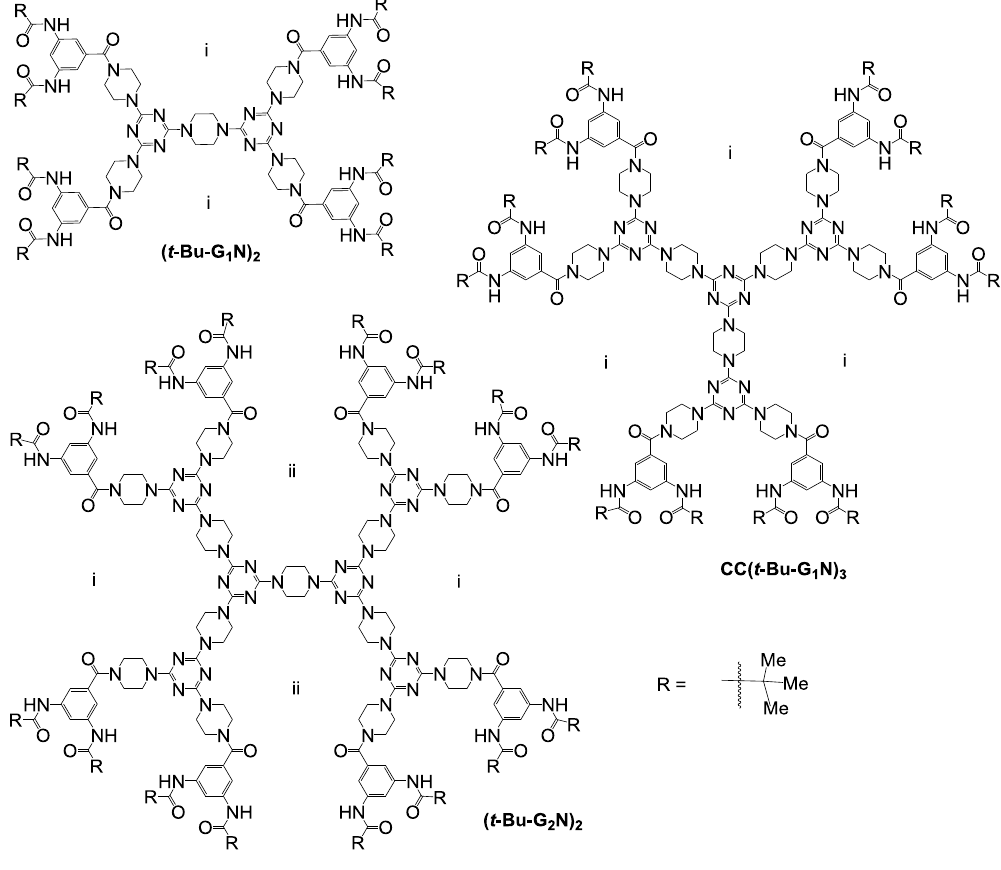
Figure 1. Structure of ( t -Bu-G 2 N ) 2 , CC( t -Bu-G 1 N ) 3 , and ( t -Bu-G 1 N ) 2